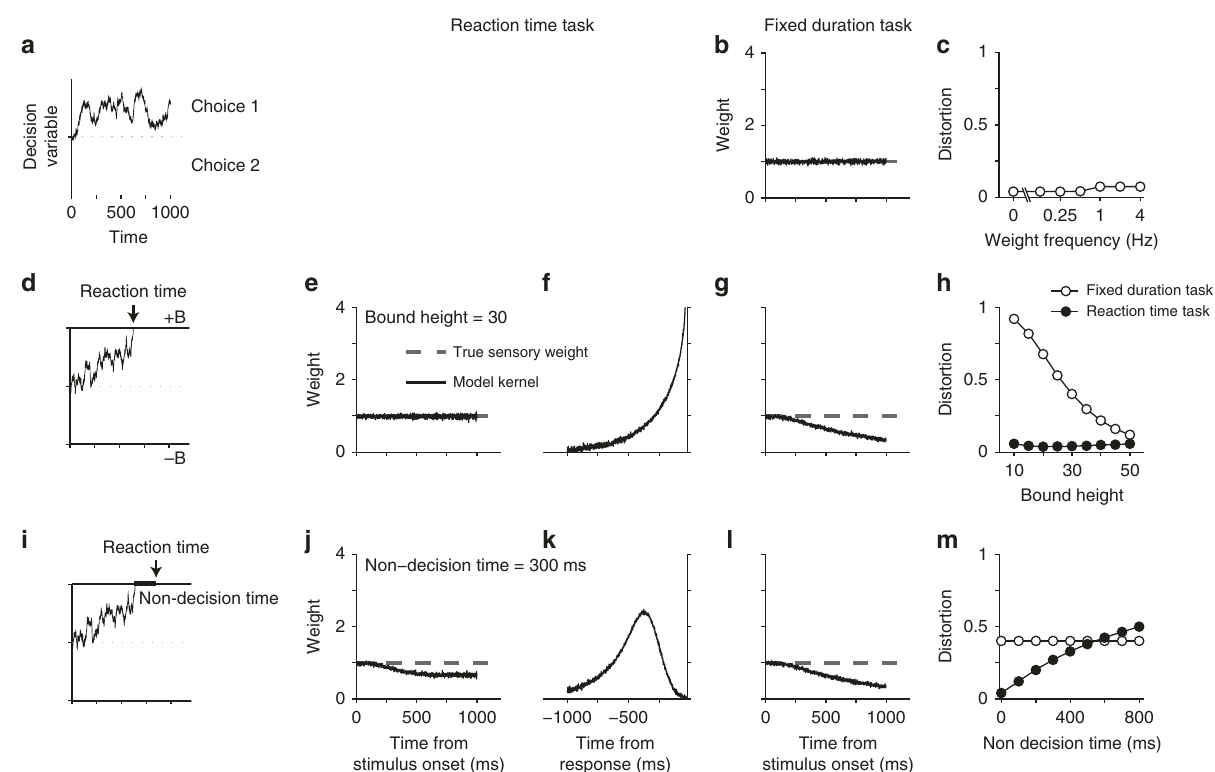
Fig. 3 Psychophysical kernels deviate from sensory weights in DDM because of incomplete knowledge about decision time. a – c Integration of evidence per se does not preclude accurate recovery of sensory weights. For an unbounded DDM that integrates momentary evidence as long as sensory inputs are available, the kernel matches the true sensory weights. In this simulation, the weight is stationary and fi xed at 1, but similarly matching results are obtained for any sensory weight ( c ; Supplementary Fig. 1). Distortion quanti fi es root-mean-square error between the psychophysical kernel and the true sensory weights (Eq. 17). d – h The decision bound does not preclude accurate recovery of sensory weights. In a bounded DDM without non-decision time, RTs are identical to decision time ( d ). Model simulations for RT tasks result in stimulus-aligned kernels that match sensory weights ( e ) and response-aligned kernels that rise monotonically ( f ), as expected for termination with bound crossing. However, stimulus-aligned kernels in fi xed-duration tasks show a monotonic decrease because later stimuli are less likely to in fl uence the choice ( g ). This deviation from true sensory weights is caused by early commitment to a choice and becomes smaller as the decision bound rises ( h ). i – m Variability of non-decision time makes reaction time an unreliable estimate of decision time, causing systematic deviations between psychophysical kernels and true sensory weights. After including non-decision time in the bounded DDM, stimulus-aligned kernels in RT tasks show a monotonic decrease because the stimuli that immediately precede the choice do not contribute to it ( j ). Response-aligned kernels show a peak, whose time is dependent on the distribution of non-decision times ( k ). Kernels for fi xed-duration tasks are not affected by non-decision time ( l ) but still show the decline caused by bound crossing, similar to g . Deviation of stimulus-aligned kernels in the RT task increases with variability of non-decision time ( m ). Standard deviation of non-decision time is assumed to be 1/3 of its mean in these simulations. All kernels are normalized according to Eq. 2 or Eq. 14 to allow direct comparison with the true sensory weights (see